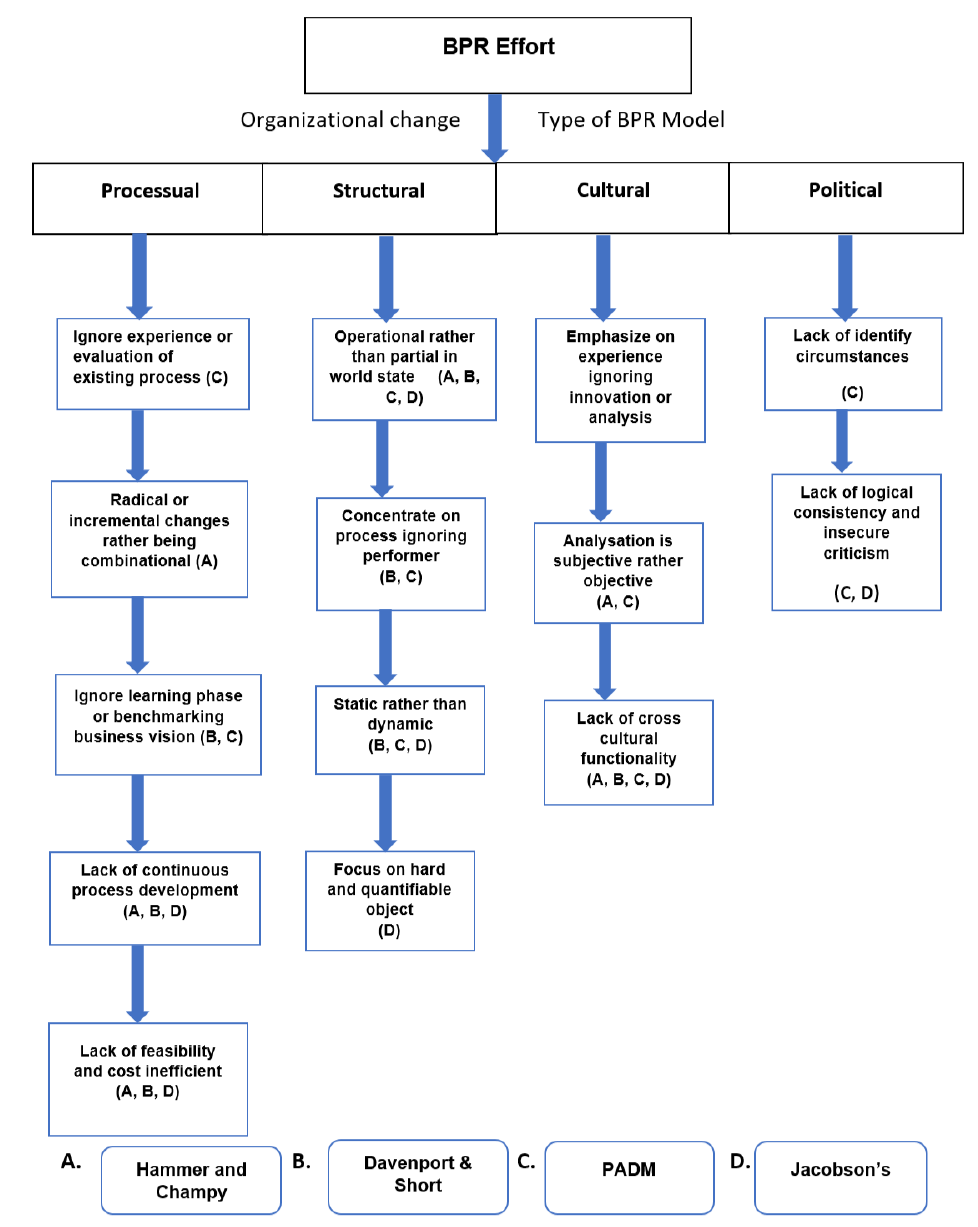
Figure 6. BPR methodology comparison framework.